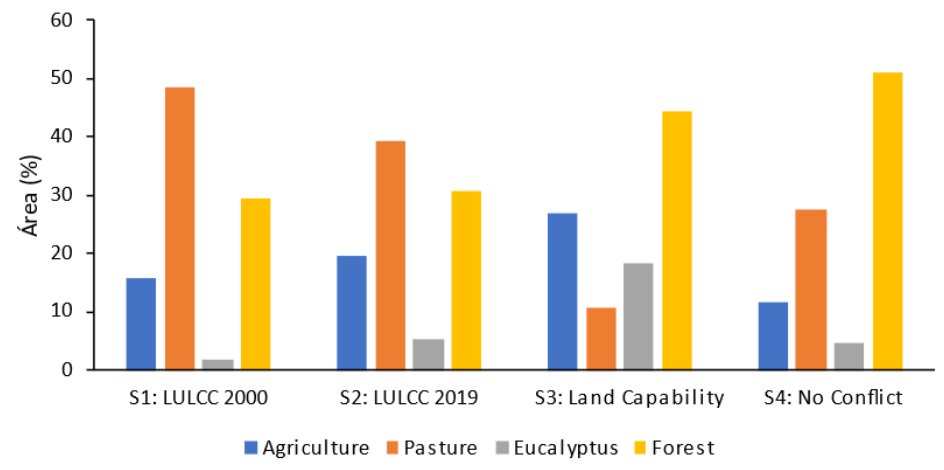
Figure 10. Distribution of main land covers in land use scenarios.